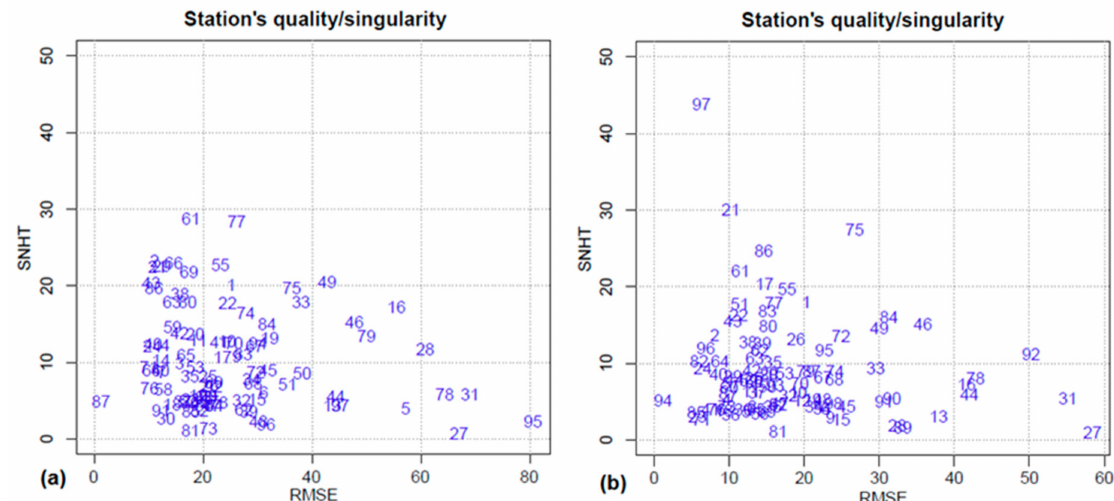
Figure 5. Plot of quality/singularity of the stations of ( a ) raw and ( b ) adjusted data.